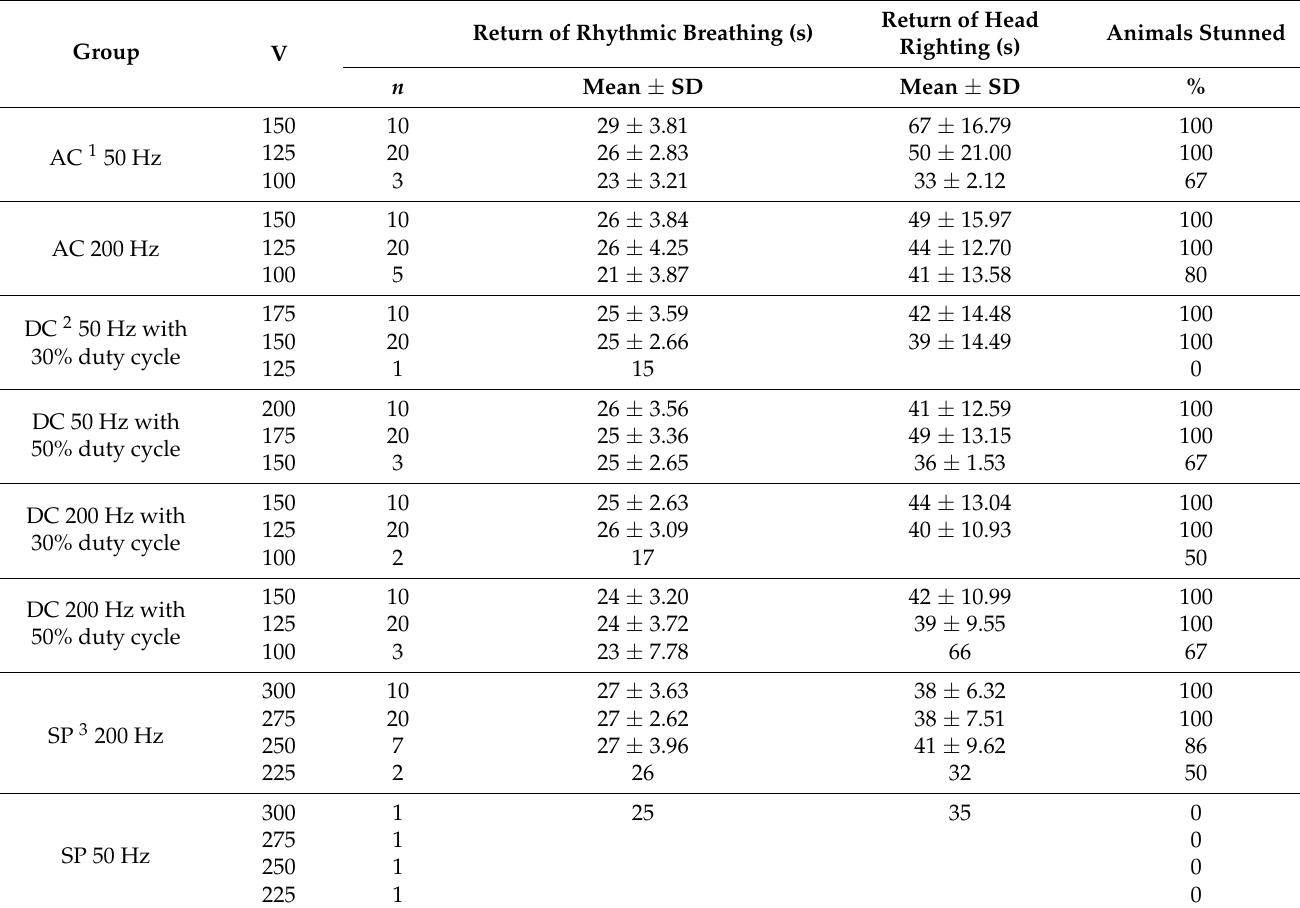
Table 4. Average times (s) for return of spontaneous physical reflexes following 1 s application of head-only stunning in turkeys. Return of Rhythmic Breathing Group V